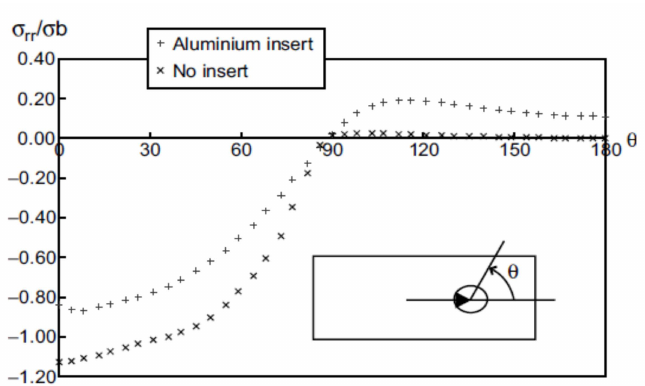
Figure 13. Distribution of normalised radial stresses against the angular position around the hole in the laminate [18].